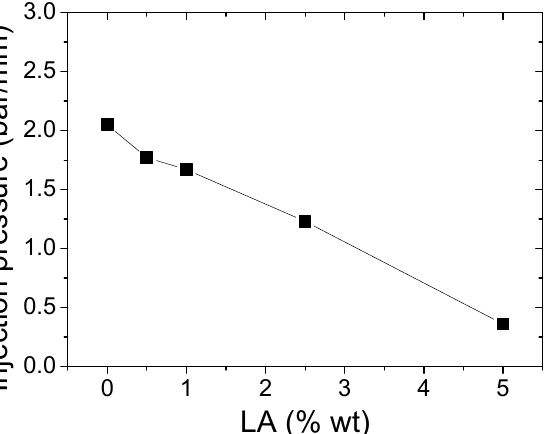
Figure 8. Spiral specimens for PA6 ( left ) and star polyamides modified with 2.5% ( center ) and 5% ( right ) 5-aminophthalic acid.